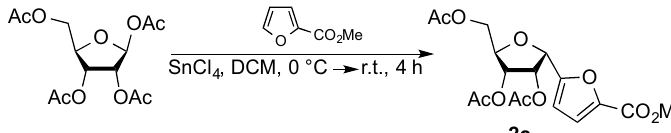
Scheme 5. Synthesis of the ribofuranosyl furan α - 2c .